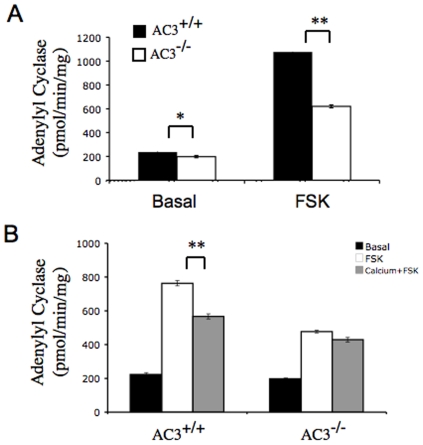
The adenylyl cyclase activity of the hypothalamus is reduced in AC3−/− mice.(A) Forskolin stimulated adenylyl cyclase activity in the hypothalamus is absent in AC3−/− mice. (B) Calcium inhibition of forskolin-stimulated adenylyl cyclase in the hypothalamus is impaired in AC3−/− mice. The adenylyl cyclase activity was assayed from homogenized hypothalamus. The forskolin concentration was 50 µM. The free calcium concentration was 19.9 µM. Data are represented as means±SEM. *, p<0.05; **, p<0.01. N = 3 for each genotype.